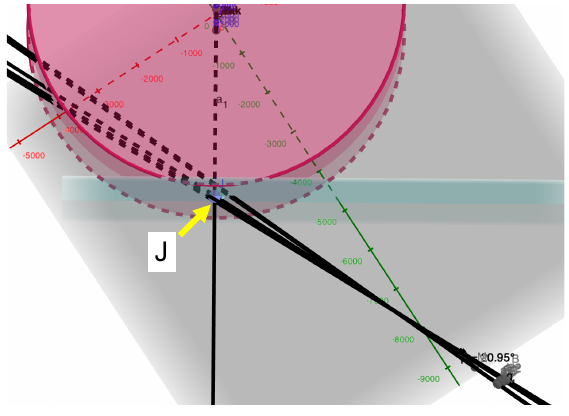
Fig. 3 . Built plane in “J” tangential to the central column